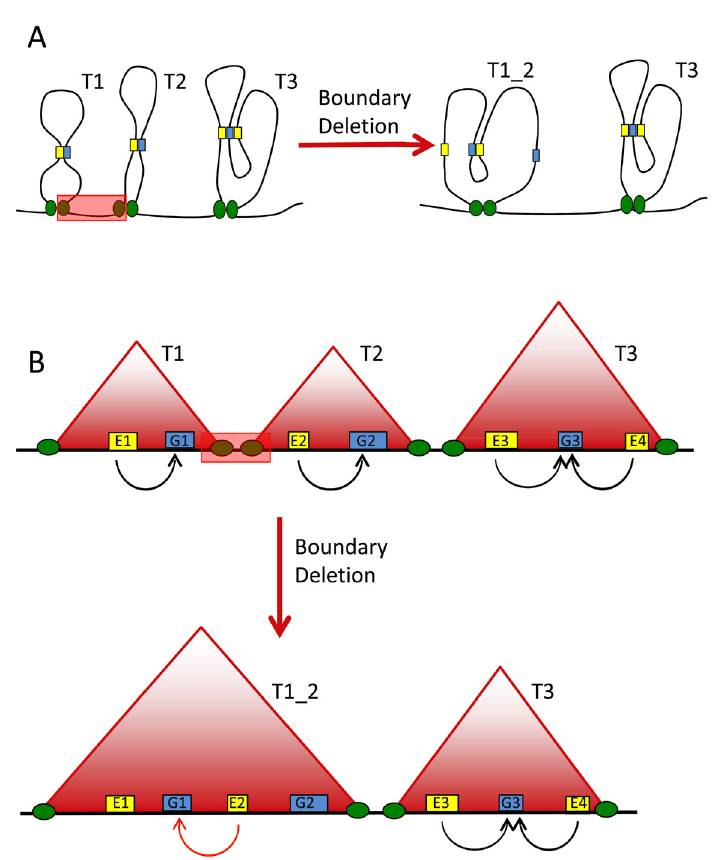
Figure 1. Schematic diagram of regulatory re-wiring following the deletion of a domain boundary. ( A ) Interactions between enhancers and their target genes occur within chromatin domains. The deletion of a boundary region leads to novel gene-enhancer interactions between previously insulated elements; this process may lead to the spatial or temporal mis-expression of genes. ( B ) The same scenario as in ( A ) is drawn as represented by a high-throughput chromosome conformation capture (Hi-C) interaction map. Red triangles: topologically associating domains; yellow boxes: regulatory elements; blue boxes: target genes; green circles: insulator elements. Further examples of pathogenic genomic rearrangements, including insulator-spanning tandem duplications, are illustrated in